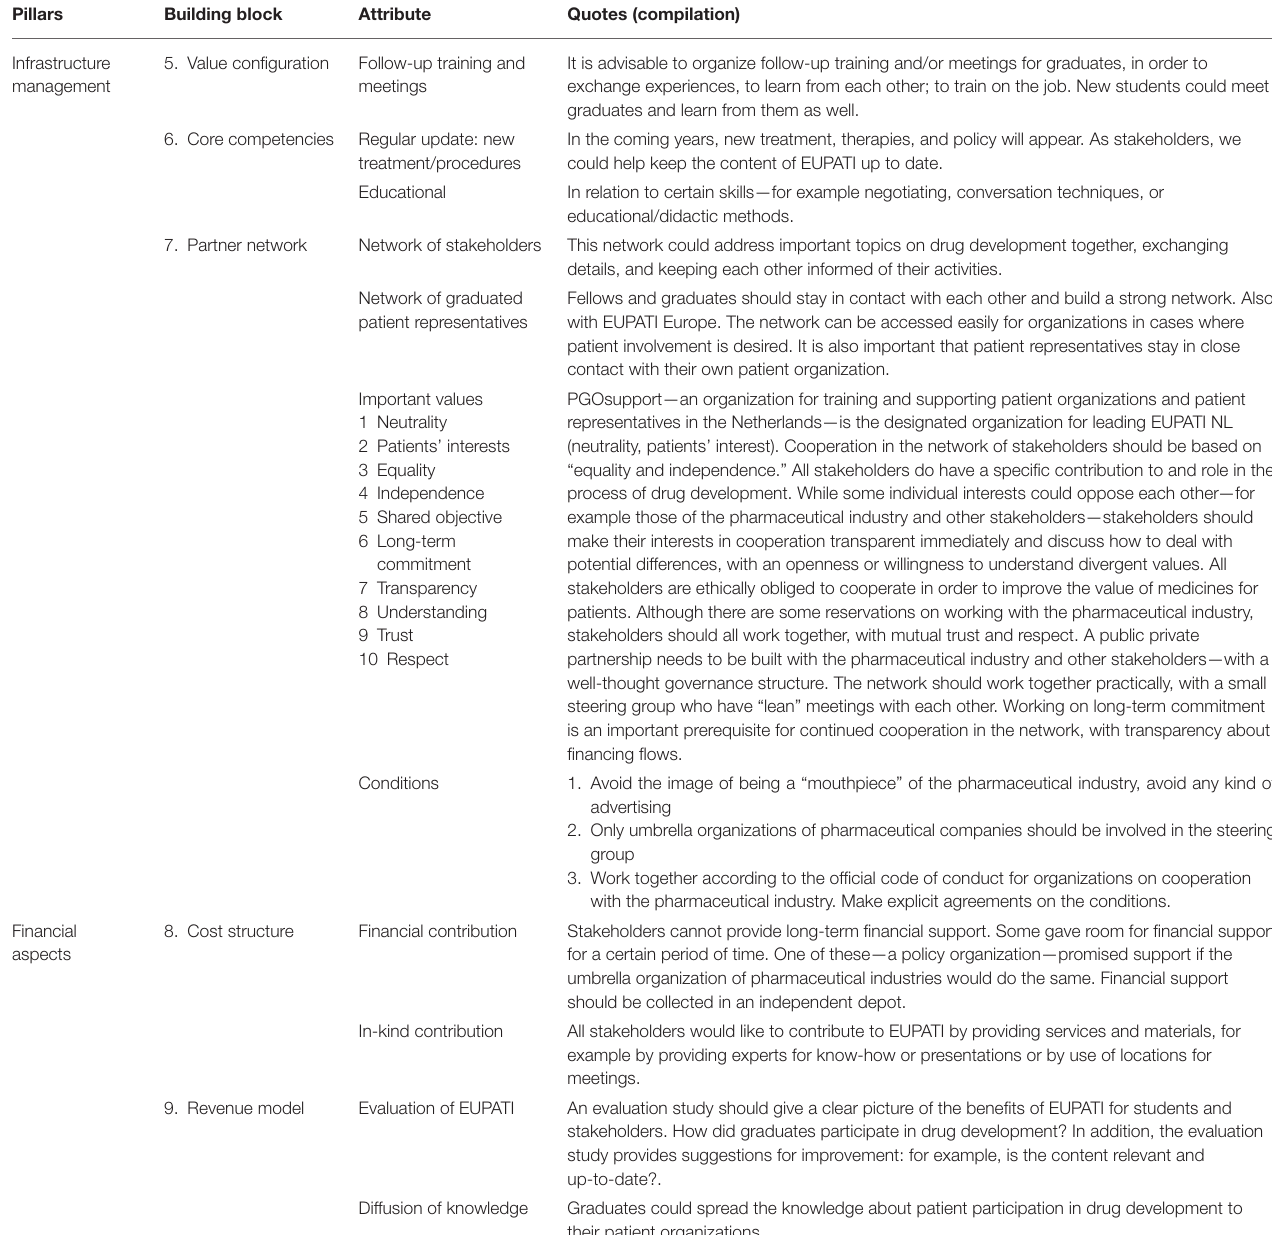
TABLE 3 | Infrastructure management and financial aspects of the Dutch EUPATI course according to stakeholders.